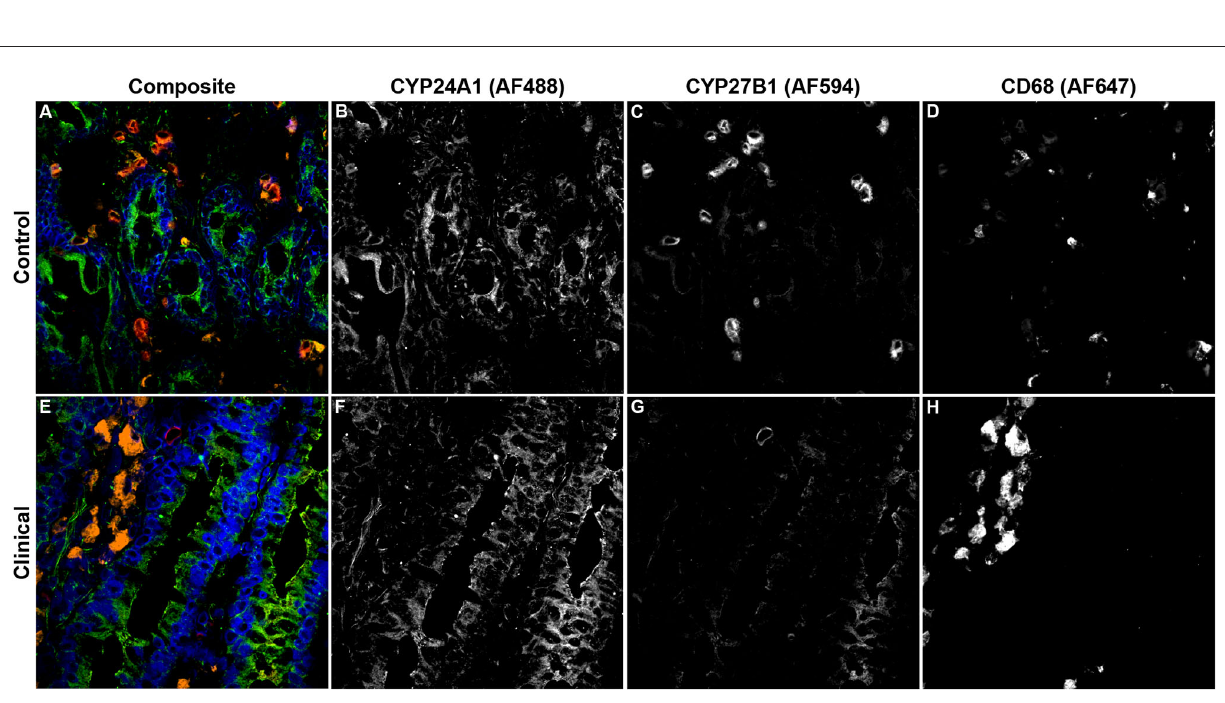
FIGURE8 Confocal microscopy images of frozen mid-ileum sections from a JD- control cow (A–D) and clinical cow (E–H) . Composite images overlaying each laser channel are presented in (A, E) . CYP24A1 (green) labeling was detected using an AF488 secondary antibody and excited on the 488nm laser (B, F) , while CYP27B1 (red) primary antibody was directly conjugated to AF594 and excited on the 561nm laser (C, G) . CD68 (orange) was labeled with an AF647 secondary antibody and excited on the 641nm laser (D, H) . Nuclei (blue) were counterstained using DAPI which was excited on the 405nm